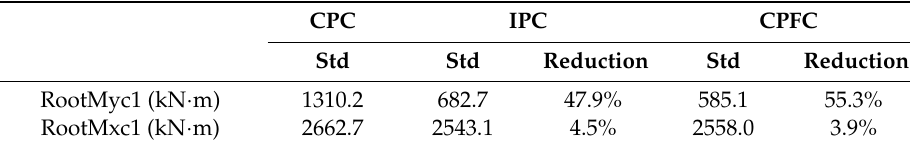
Figure 6. The blade root bending moments. ( a ) The blade root out-of-plane bending moments; ( b ) The blade root in-plane bending moments. Table 2. Standard deviation of blade root bending moments.